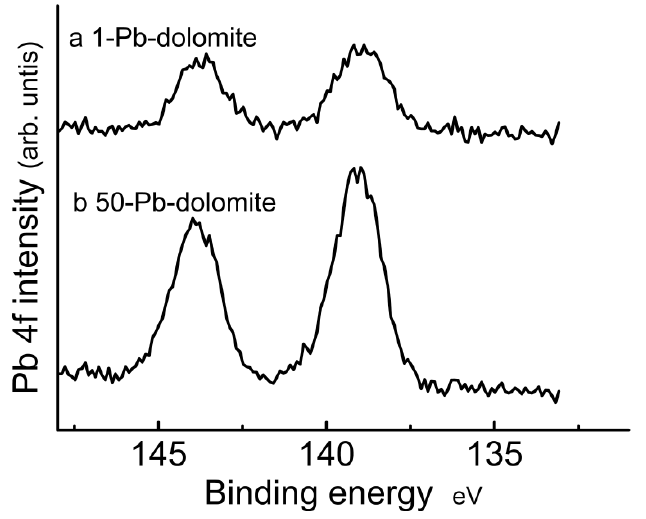
Figure 2. XPS narrow scan of dolomite surface for samples after 15 days exposure to 1 mg/L PbCl 2 solution and after 15 days exposure to 50 mg/L PbCl 2 solution. The studied spectral peaks were Pb4f 5/2 and Pb4f 7/2 .